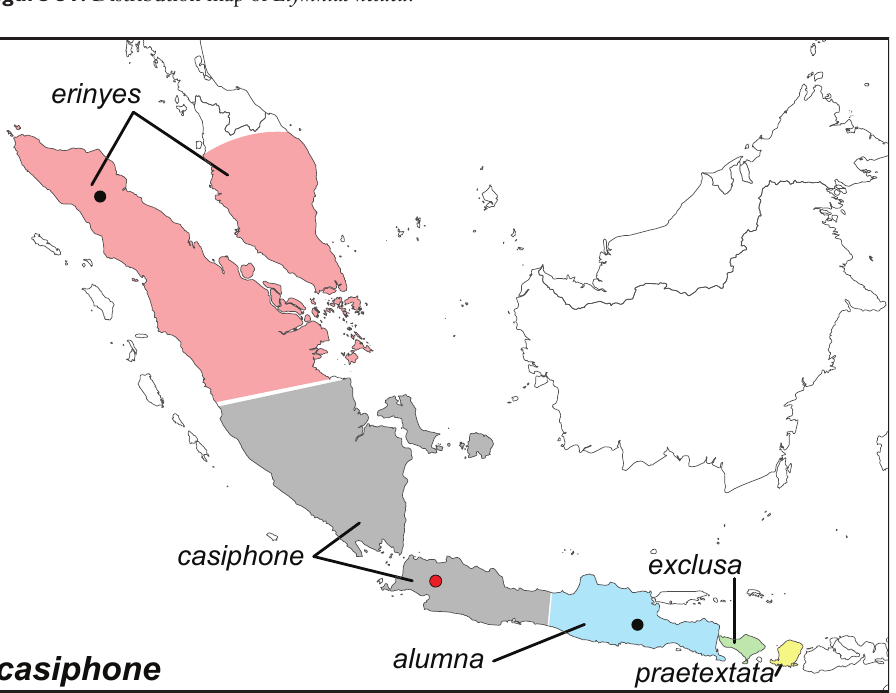
Figure 52. Distribution map of Elymnias casiphone